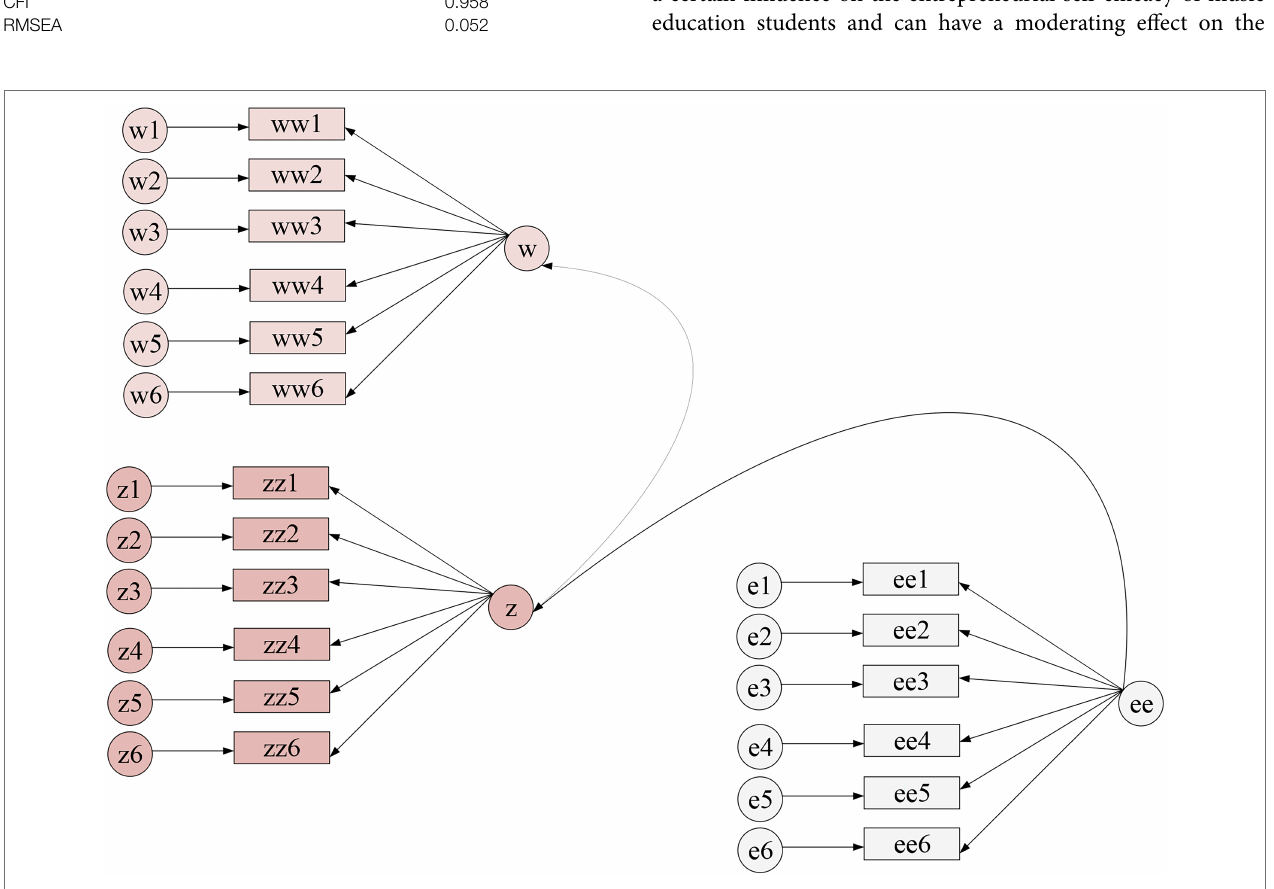
FIGURE 3 | Output result of Amos(1).